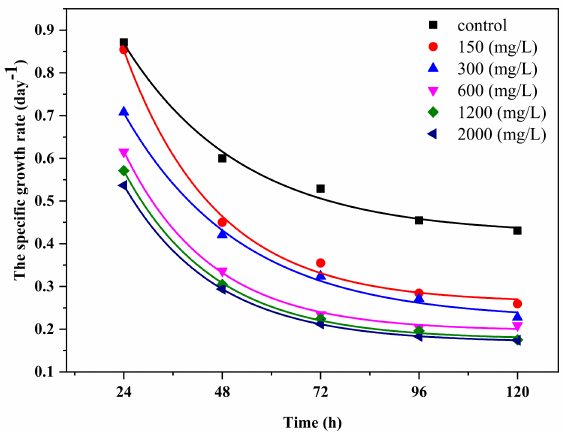
Figure 4. Growth curves of Chlorella vulgaris with different concentrations of the TiO 2